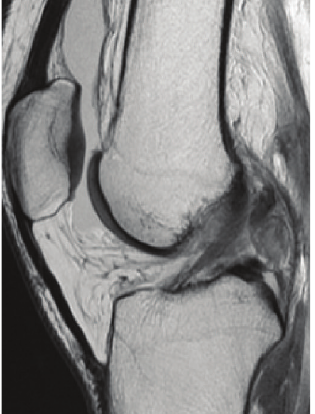
Figure 4: 24-year-old female with localized PVNS at the posterior cruciate ligament (case #P5). Bursa suprapatellaris is clearly dis- tended with fluid. Sagittal proton density-weighted MR